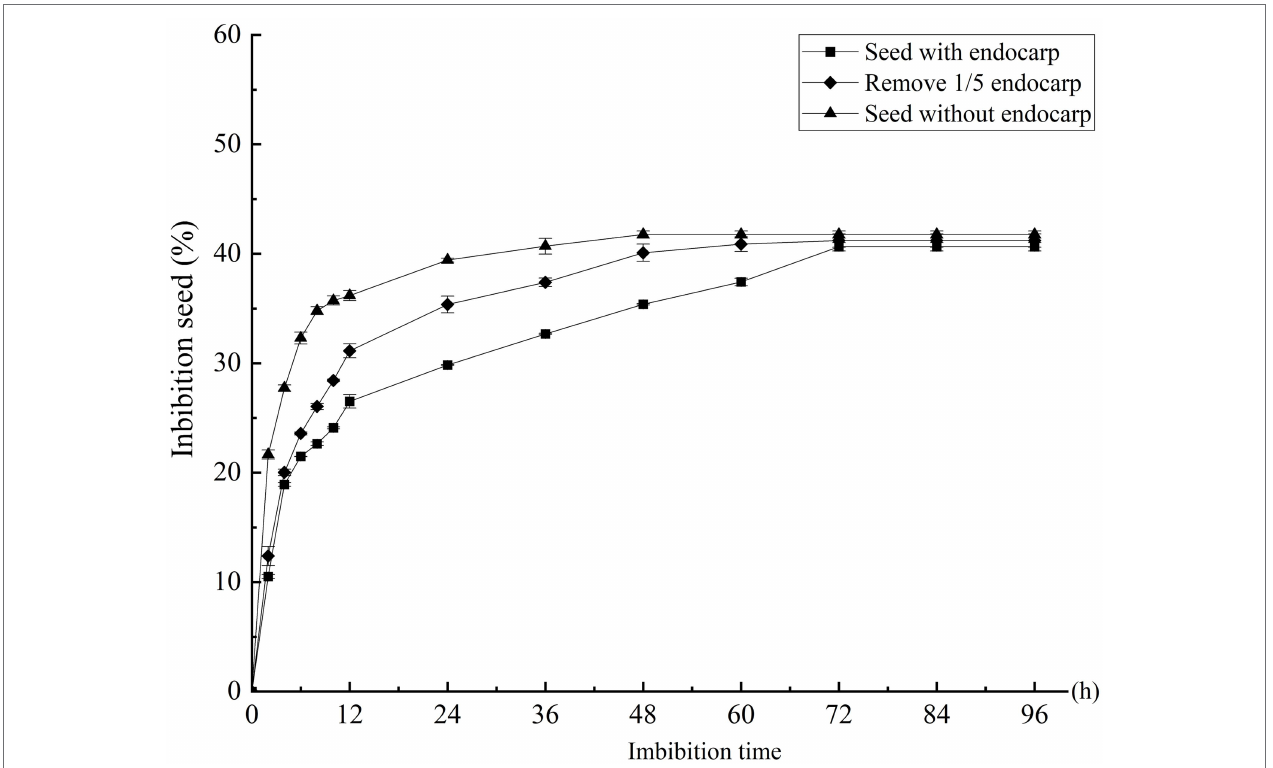
FIGURE 3 | Effect of different treatments on the water absorption rate of Cinnamomum migao seeds. The x -axis denotes the water imbibition time of the seeds, and the y -axis denotes the water absorption percentage. Data are presented as means ± standard deviations for three replicates. Three replicates of 30 seeds each were used for each